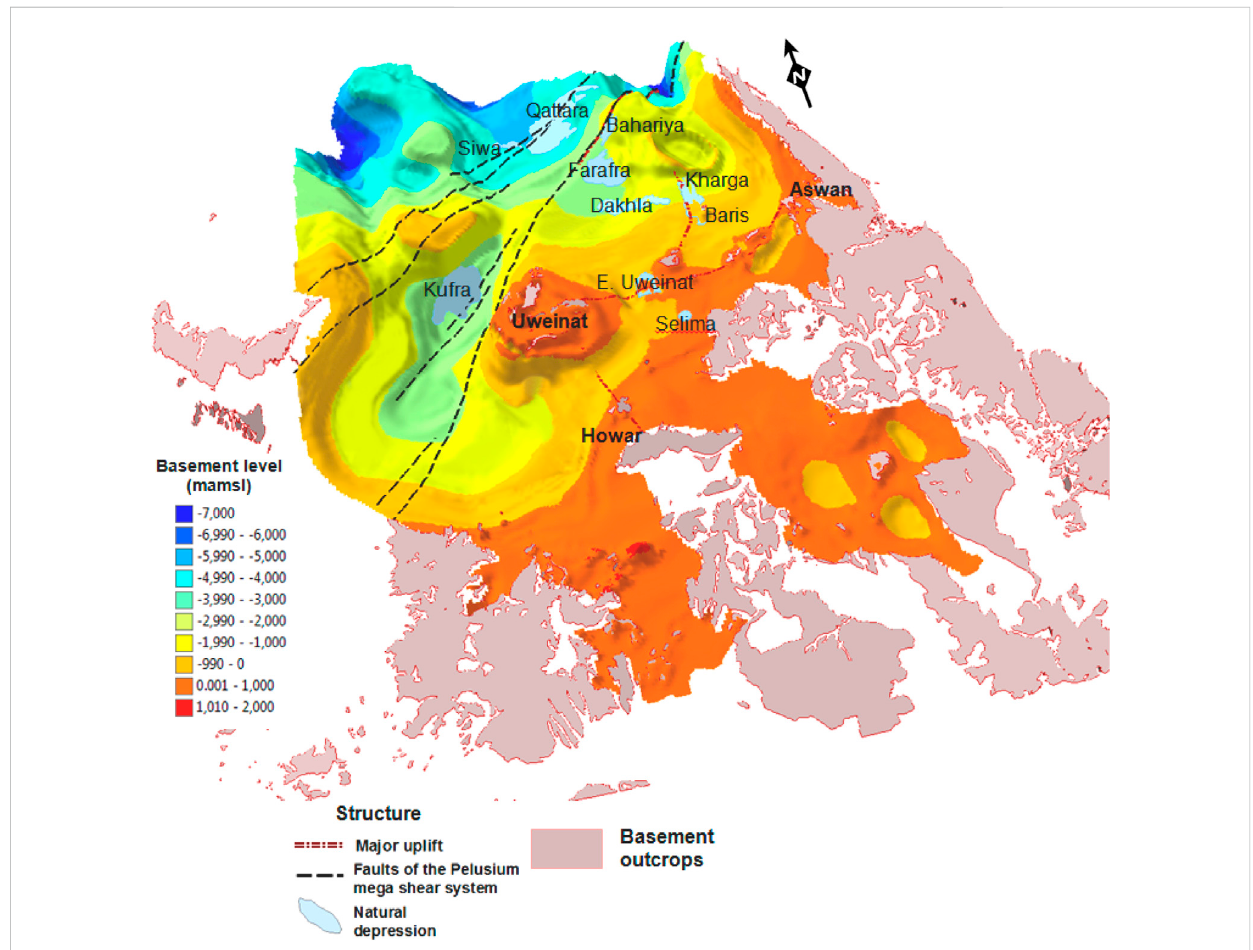
FIGURE 8 Basement relief 3D map extracted over the NSAS showing thickening of the sedimentary sequences to the north and along the northeast trending PMS (After Mohamed, 2016; Mohamed et al., 2017).